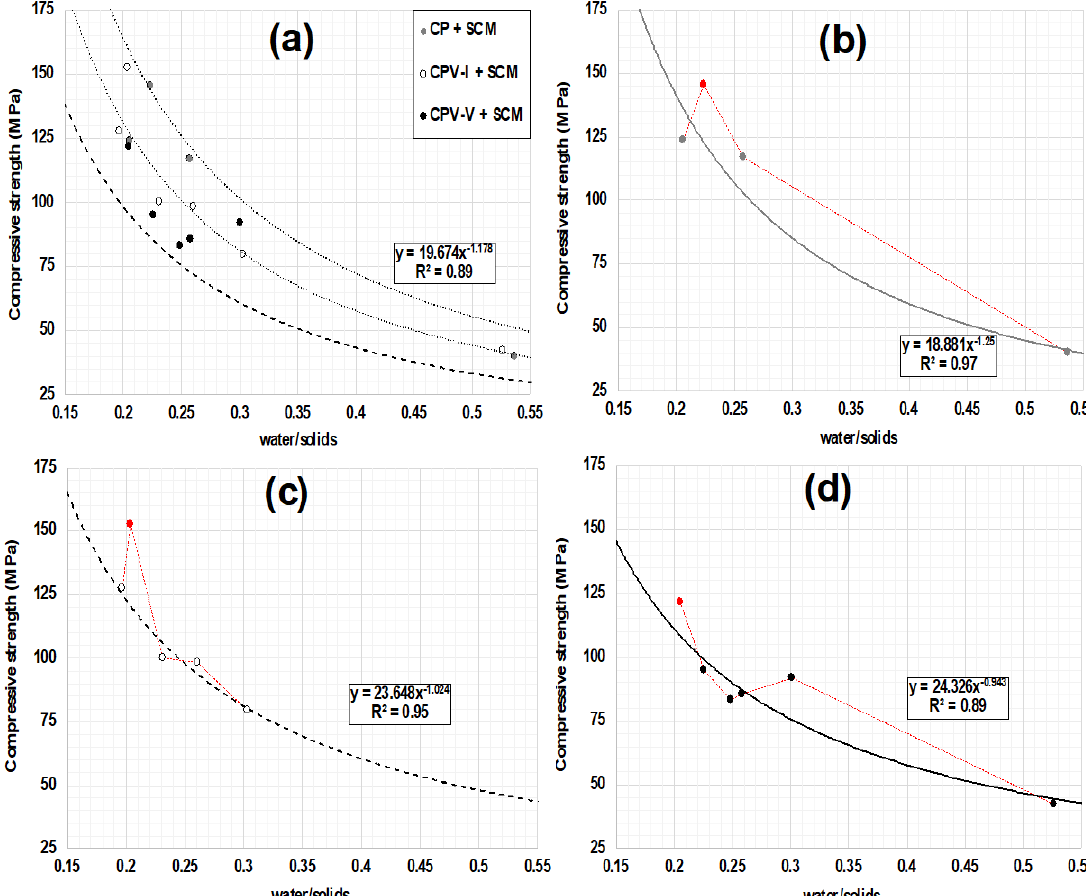
Figure 5. Effect of water/solids on the compressive strength (a) all mixtures (b) Pure clinker (c) Portland cement CPV-I (d) Portland cement